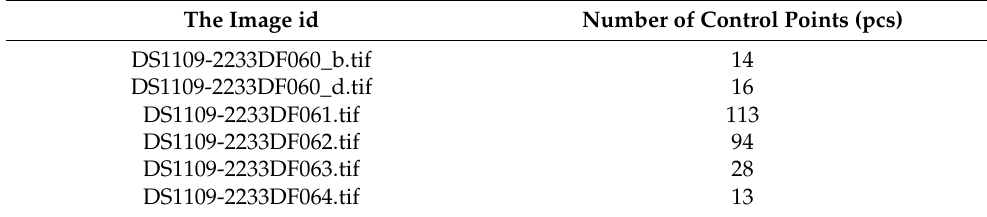
Table 1. The number of control points for georeferencing the CORONA images. The Image